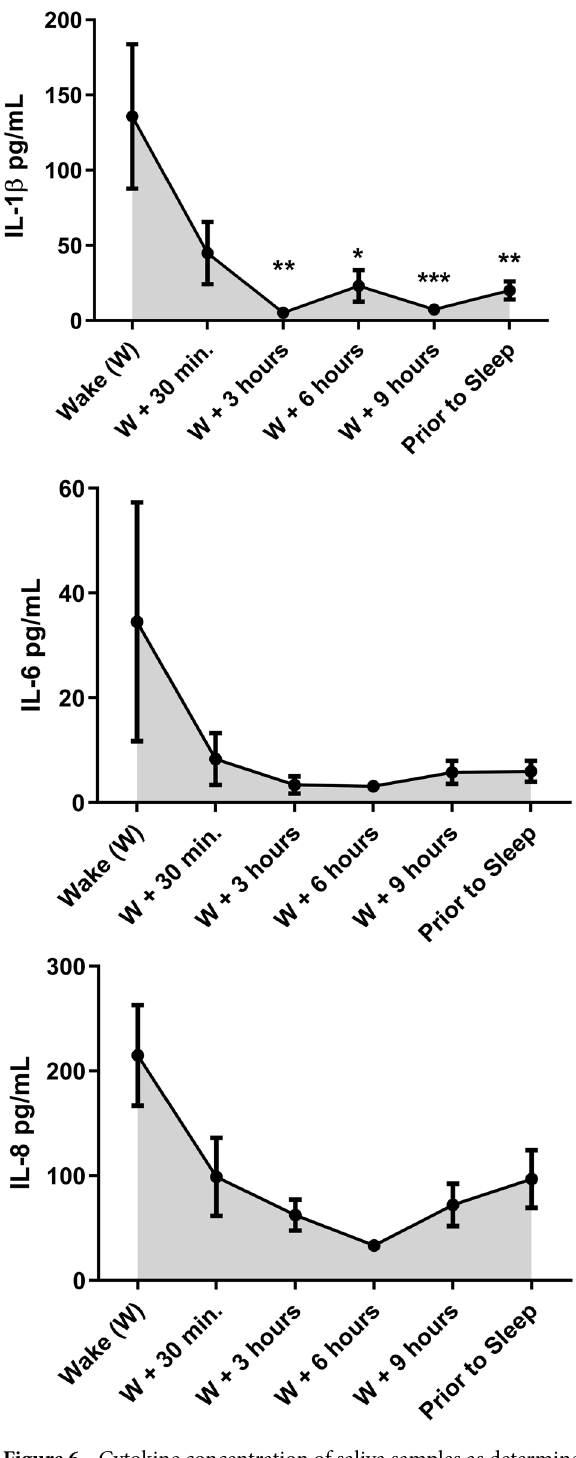
Figure 6. Cytokine concentration of saliva samples as determined by multiplexing analysis across 12 subjects. Data are shown as mean ± SE across subjects per time of collection for ( A ) IL-1β, ( B ) IL-6, and ( C ) IL-8. Asterisk denotes significant difference from cytokine concentration at wake, * p < 0.05, ** p < 0.01, and ** p < 0.001 as determined by repeated-measures